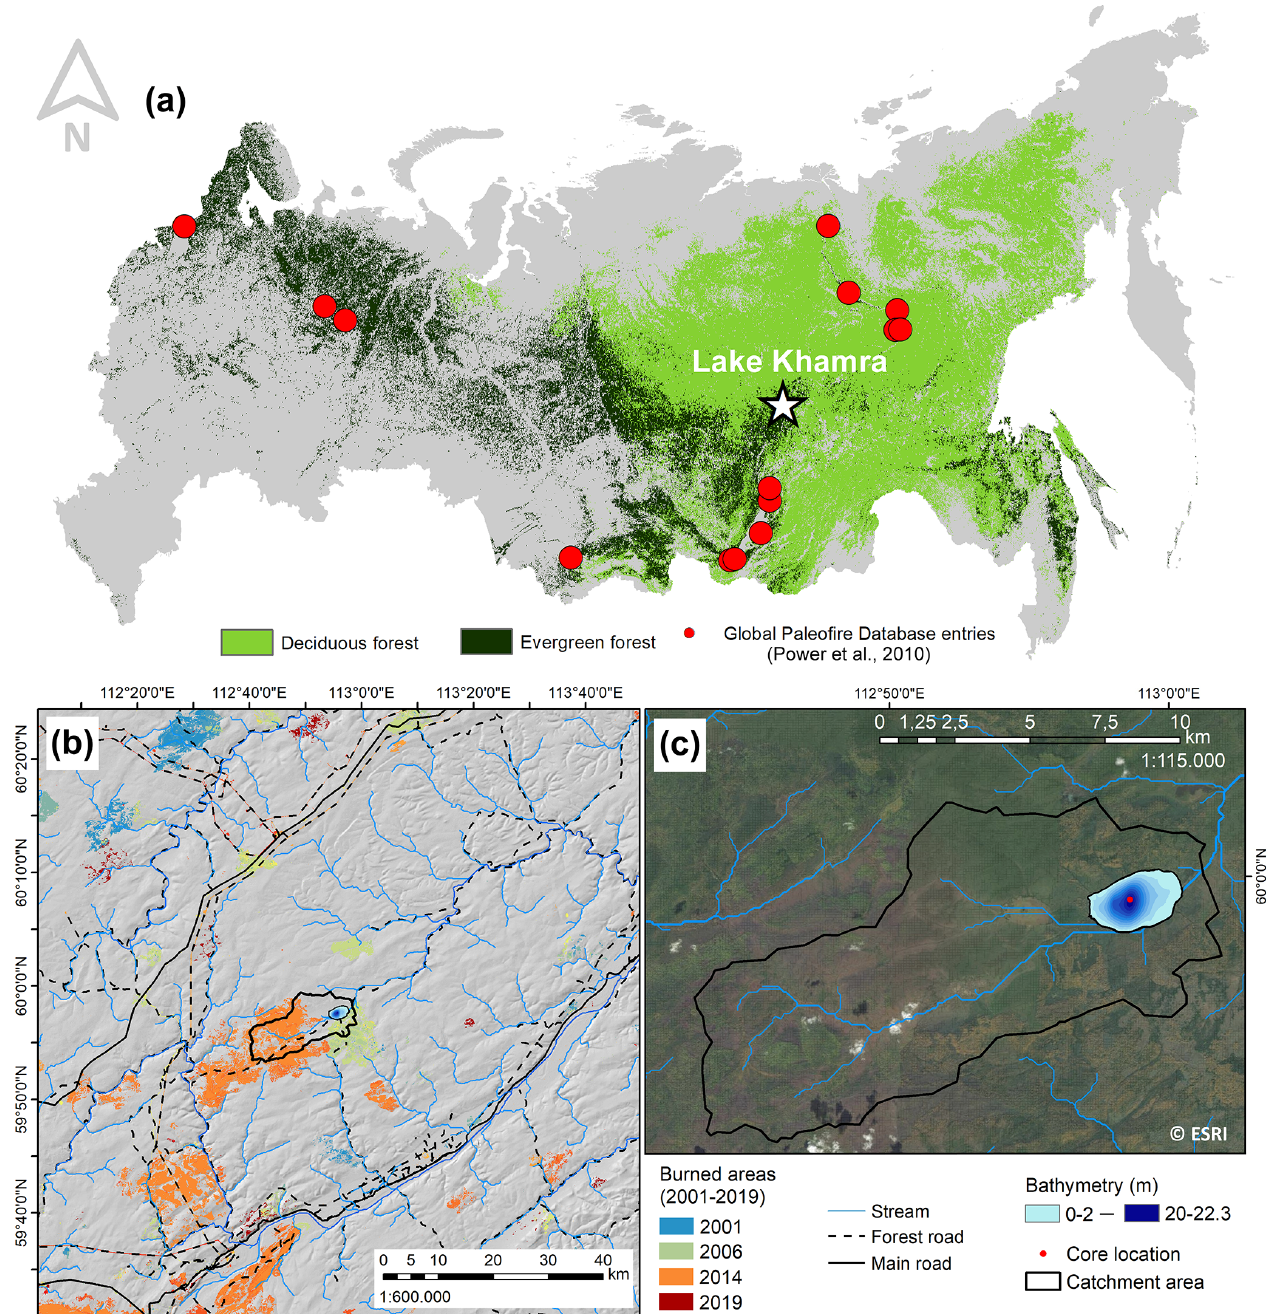
Figure 1. (a) Position of Lake Khamra and existing Global Paleofire Database entries (last access: 6 October 2020) within the deciduous and evergreen boreal forests of Russia (land cover classification based on © ESA Climate Change Initiative Land cover project, provided via the Centre for Environmental Data Analysis (CEDA). (b) Infrastructure and burned areas 2001–2019CE (Giglio et al., 2018; Hansen et al., 2013) in the vicinity of the lake (centre). (c) Lake Khamra with bathymetry and catchment area (black line) (service layer credits: Esri, DigitalGlobe, GeoEye, i -cubed, USDA, USGS, AEX, Getmapping, Aerogrid, IGN, IGP, swisstopo, and the GIS User